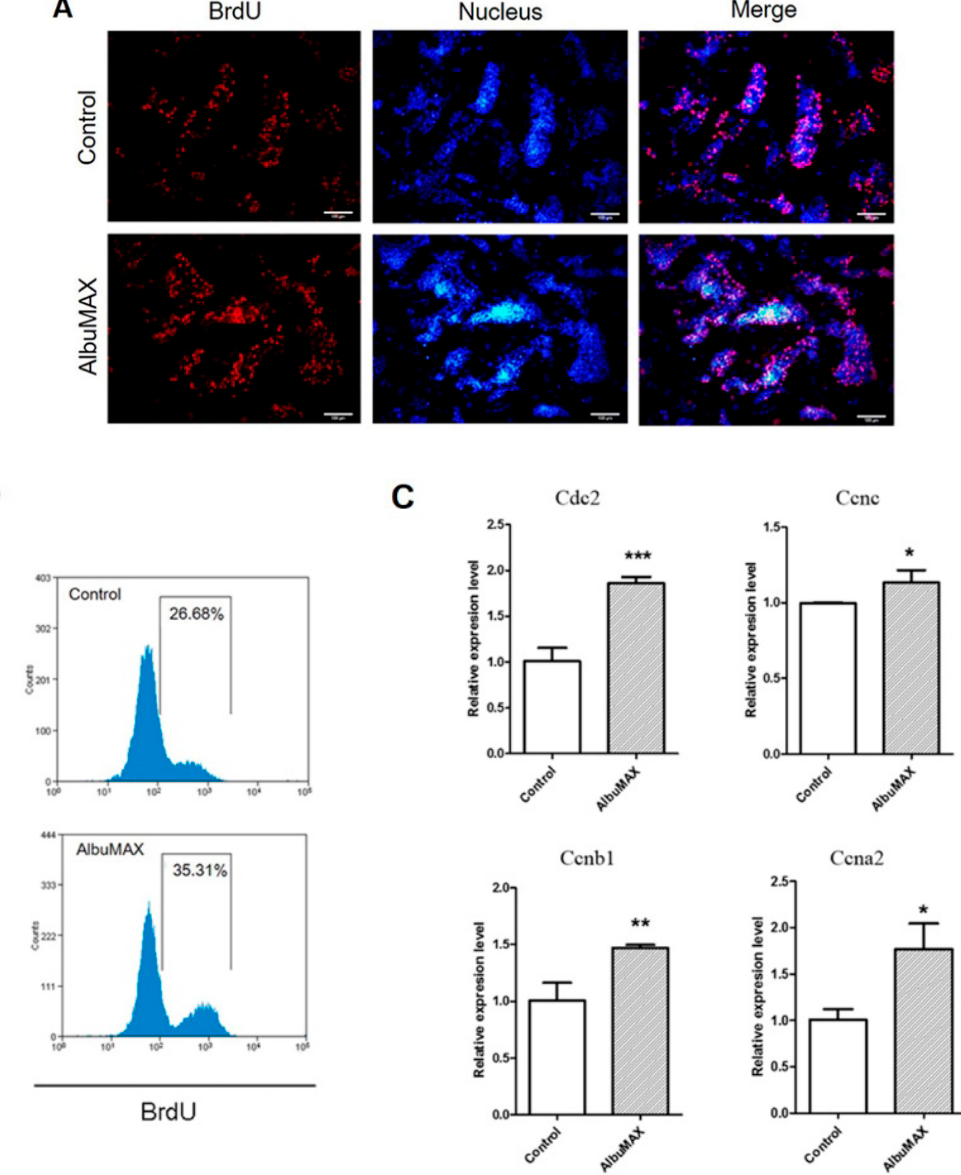
Figure 3. AlbuMAX promotes induced pluripotent stem cells (iPSCs) proliferation. ( A ) Immunofluorescence staining of BrdU (Red) in porcine iPSCs. Nuclei were stained with Hoechst 333342 (Blue). Scale bar, 100 μ m; ( B ) Analysis of BrdU positive cells by flow cytometry. * p < 0.05, ** p < 0.01, *** p < 0.001. ( C ) Quantitative RT-PCR analyzed the expression of cell cycle related genes.